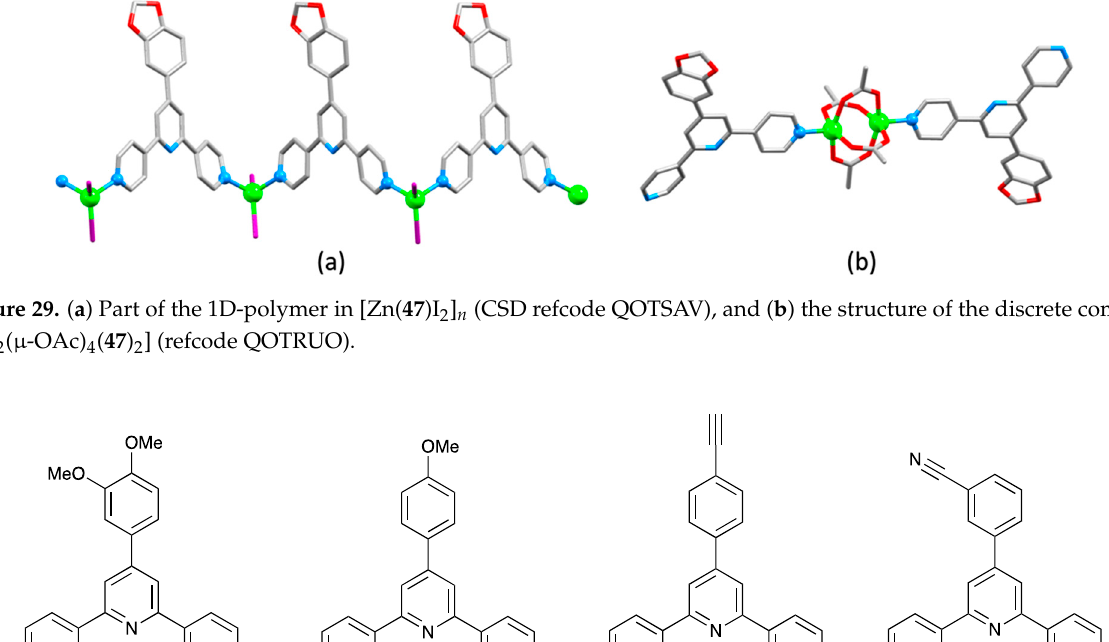
Molecules 2021 , 26 , x FOR PEER REVIEW 30 of 50